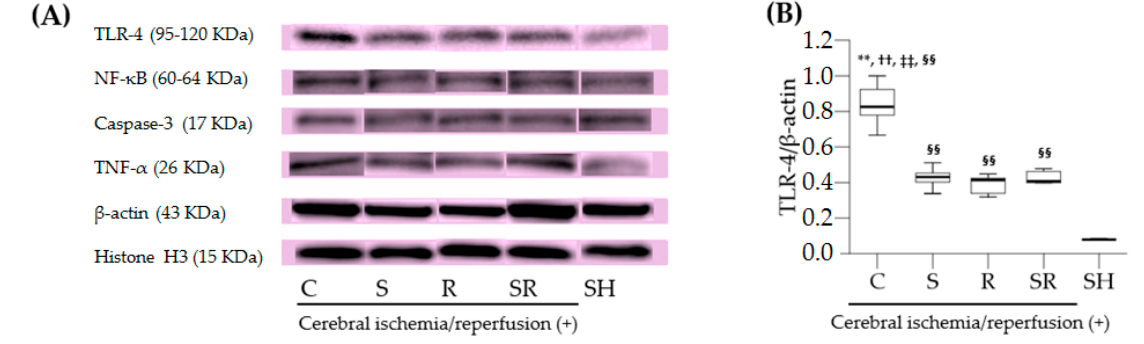
4 of 12 Figure 2. ( A ) Representative photomicrographs (×800) from a single rat with TUNEL staining in the hippocampal CA1 regions one day after transient global cerebral ischemia. Apoptotic cells (arrows) show a blue-stained apoptotic body. ( B ) The percentage of apoptotic cells. §§ p < 0.01 for Group SH; ‡ p < 0.05 for Group SR.